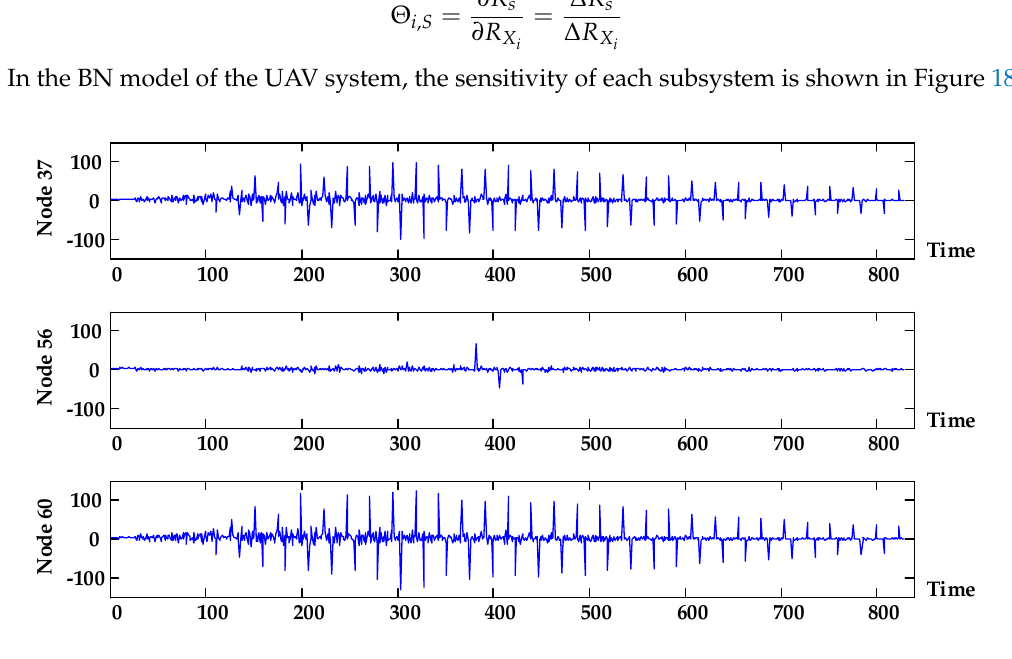
Figure 18. System sensitivity to three subsystems.